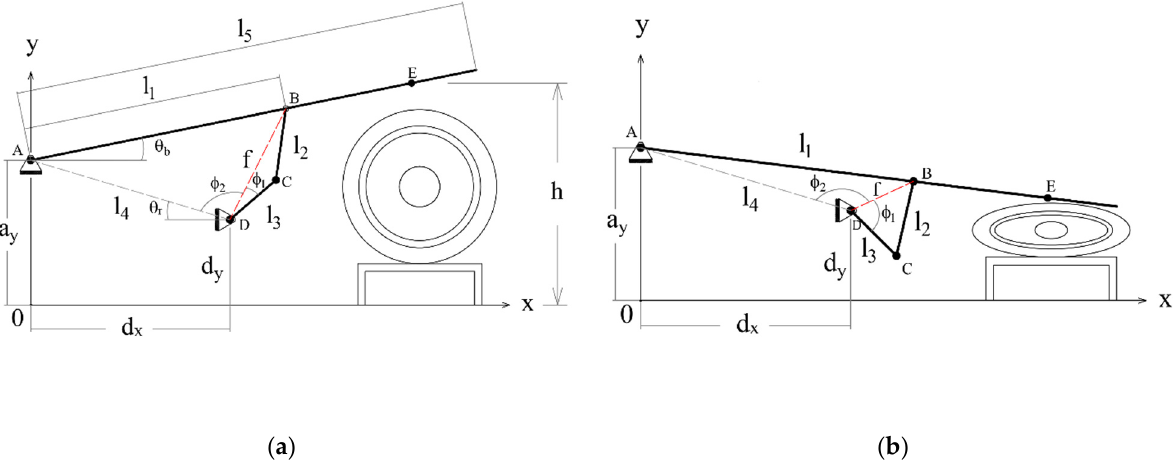
Figure 6. Conceptual diagram of the mechanism with some intermediate variables added; ( a ) initial position; ( b ) final position.